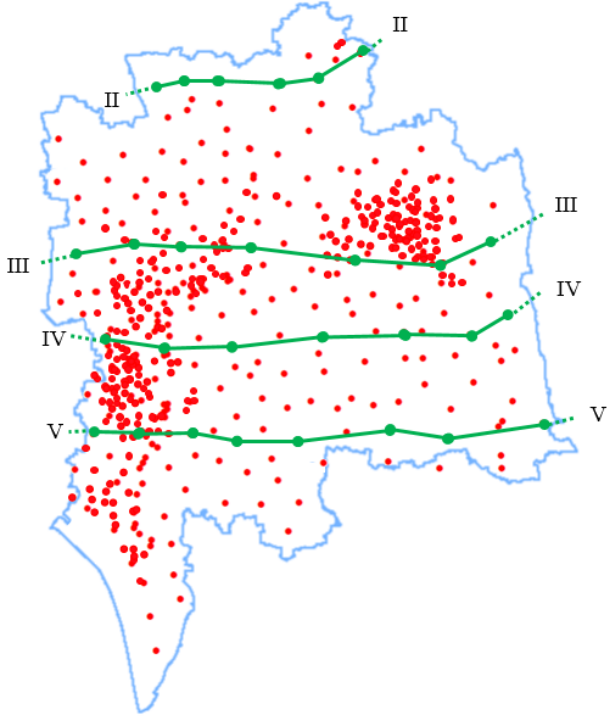
Figure 7. Borehole locations and lines connecting boreholes along east-west oriented geological profiles.